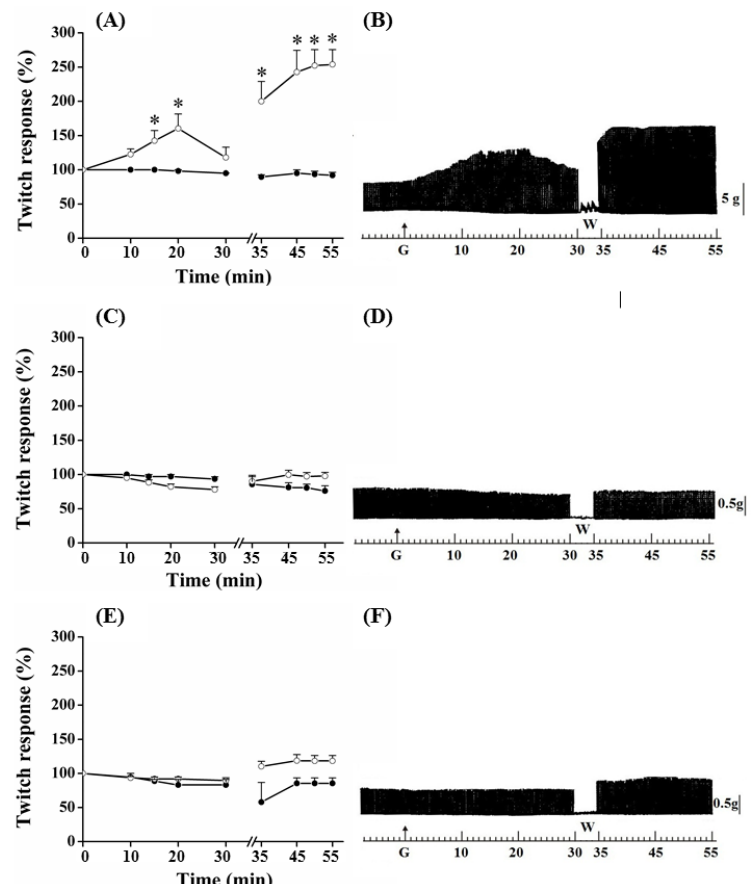
Figure 2. Effect of guanidine (10 mM) (white circles) for 30 min on the twitch response of the PND (A), EDL (C) and SOL (E) (n = 8/each) in comparison with